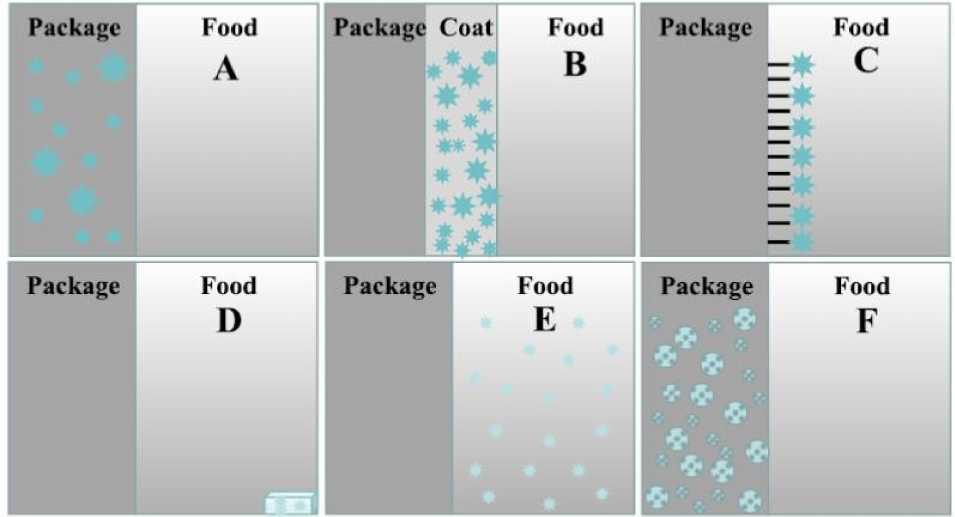
Figure 1. Schematic representation of various methods for incorporation of essential oils into packaging materials: ( A ) direct addition into packaging material; ( B ) incorporation into coatings; ( C ) immobilization onto substrates; ( D ) entrapment into physical carriers; ( E ) addition into headspace; ( F ) incorporation into matrices through carriers. Reprinted with permission from [17]; Copyright 2021